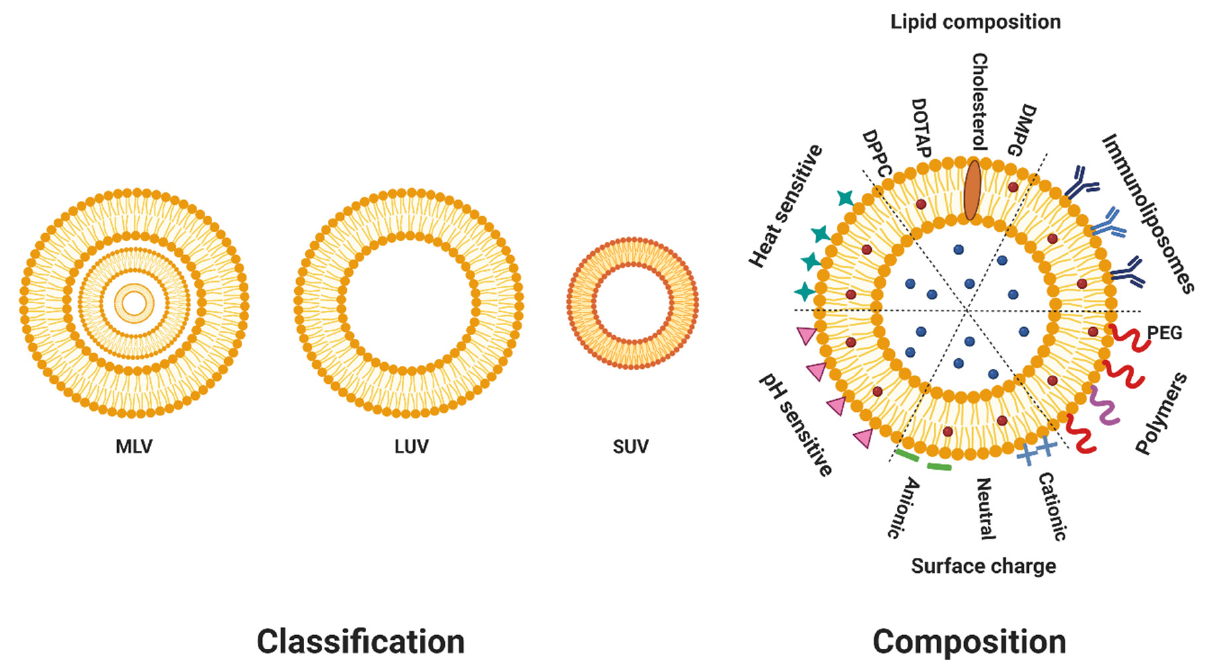
Figure 1. Classification and composition of liposomes. Liposomes can be classified based on their size, their lamellarity, and their composition. The red dots represent hydrophobic drugs whereas the blue ones represent hydrophilic drugs.